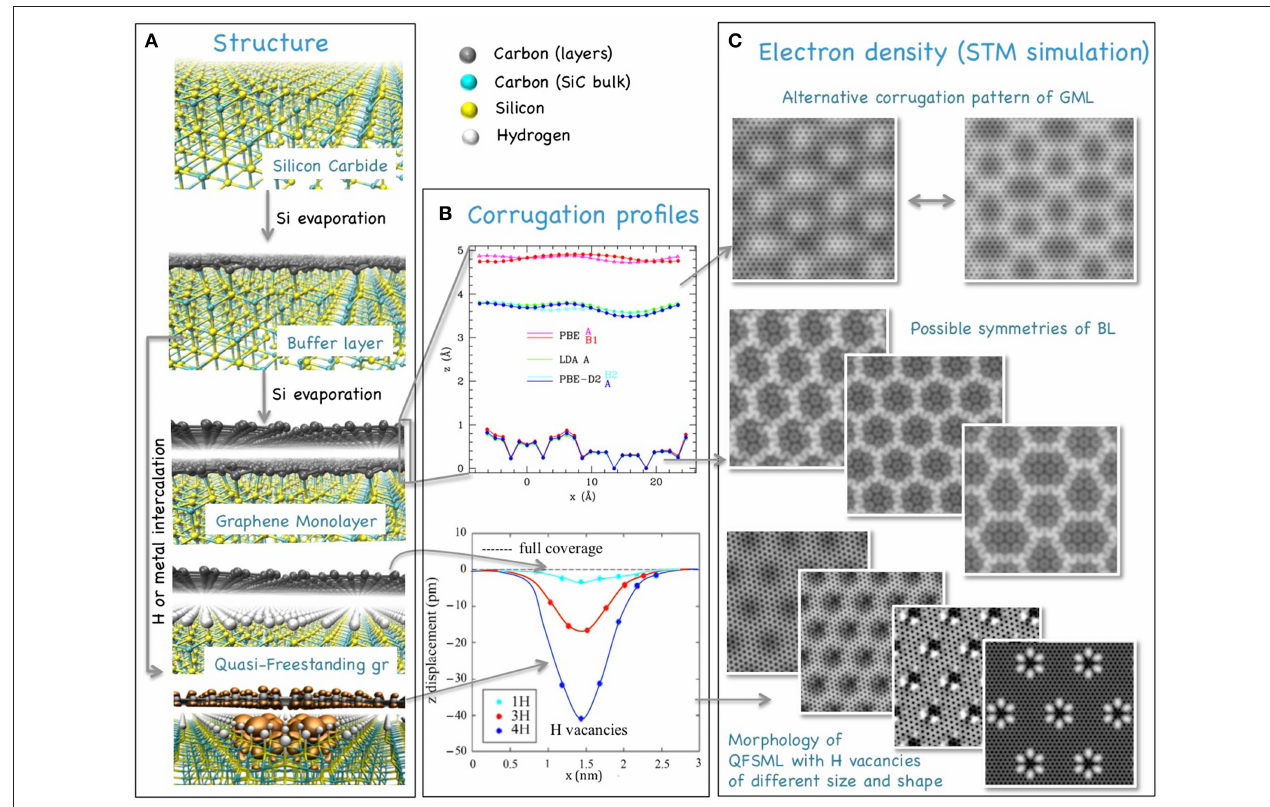
FIGURE 1 | A summary of the features of the SiC supported “graphenes.” (A) A scheme of the sheets formation: From top to bottom the pictures report the bulk SiC, the buffer layer, the graphene monolayer detaching upon formation of a subsequent buffer layer, and the quasi-freestanding forming upon intercalation of H underneath the buffer layer; the latter is also represented with vacancies in the H intercalating layer: the localized electronic states due to dangling Si bonds are represented as iso-charge-density surfaces in orange; arrows indicate the evolution flow and a legend for the atom color is reported aside. (B) Corrugation profiles of graphene sheet and buffer in the MLG system (upper plot, different colors correspond to different density functionals used for the calculation and/or different corrugation pattern, indicated) and of the quasi freestanding layer in the presence of H vacancies of increasing size (as reported, lower plot); arrows connect the corresponding parts of the structures. (C) Simulated STM images of the different systems. From top to bottom: two alternative corrugation patterns of the graphene monolayer; possible different symmetries of the moiré pattern of bonding/corrugation of the buffer layer; localized states produced by H vacancies of different shape and size. The calculations of MLG (top) and the last one of the QFMLG (bottom, foreground) are obtained with the 6 √ 3 6 √ 3 R30 SiC /13 13 gr supercell, the others × × with the √ 31 7 R21.787 gr . Plots and pictures of (B,C) are reproduced with permission for adapting or using data from Cavallucci and Tozzini √ 31R8.95 SiC 7 × × (2016, 2018) , Cavallucci et al. (2018), Murata et al.